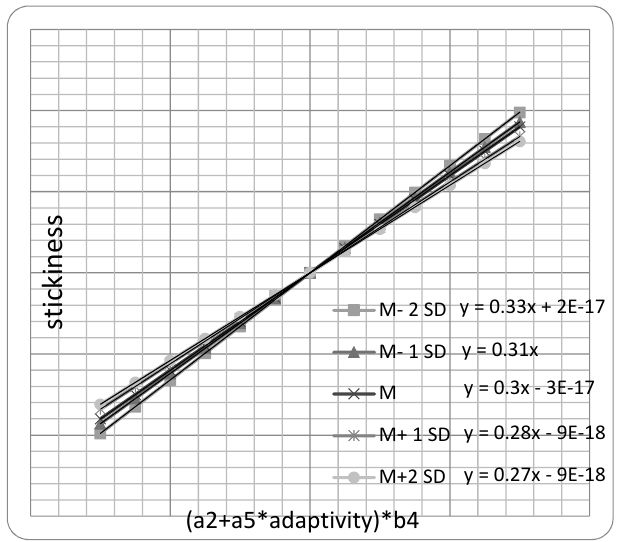
Figure 2. The effect of moderated mediation (perceived usefulness -> emotional connection -> stickiness).